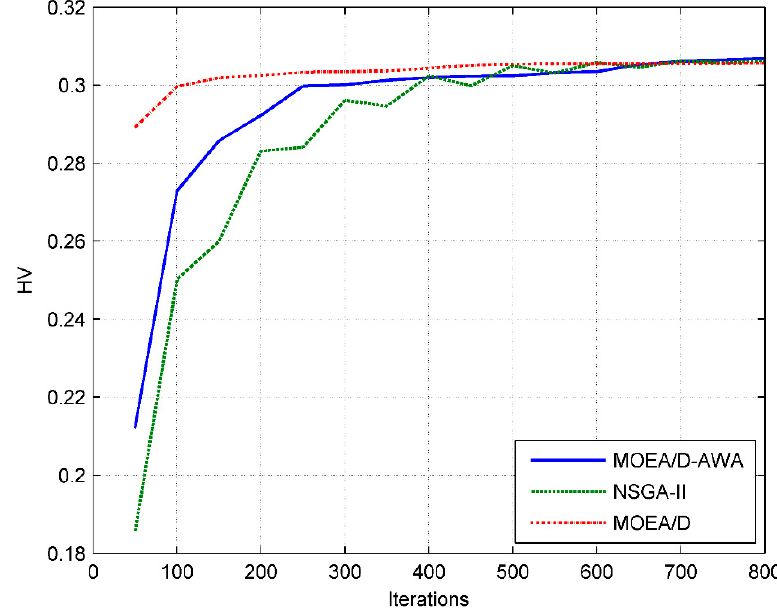
Figure 5. Hyper-volume index convergence curves of different algorithms.